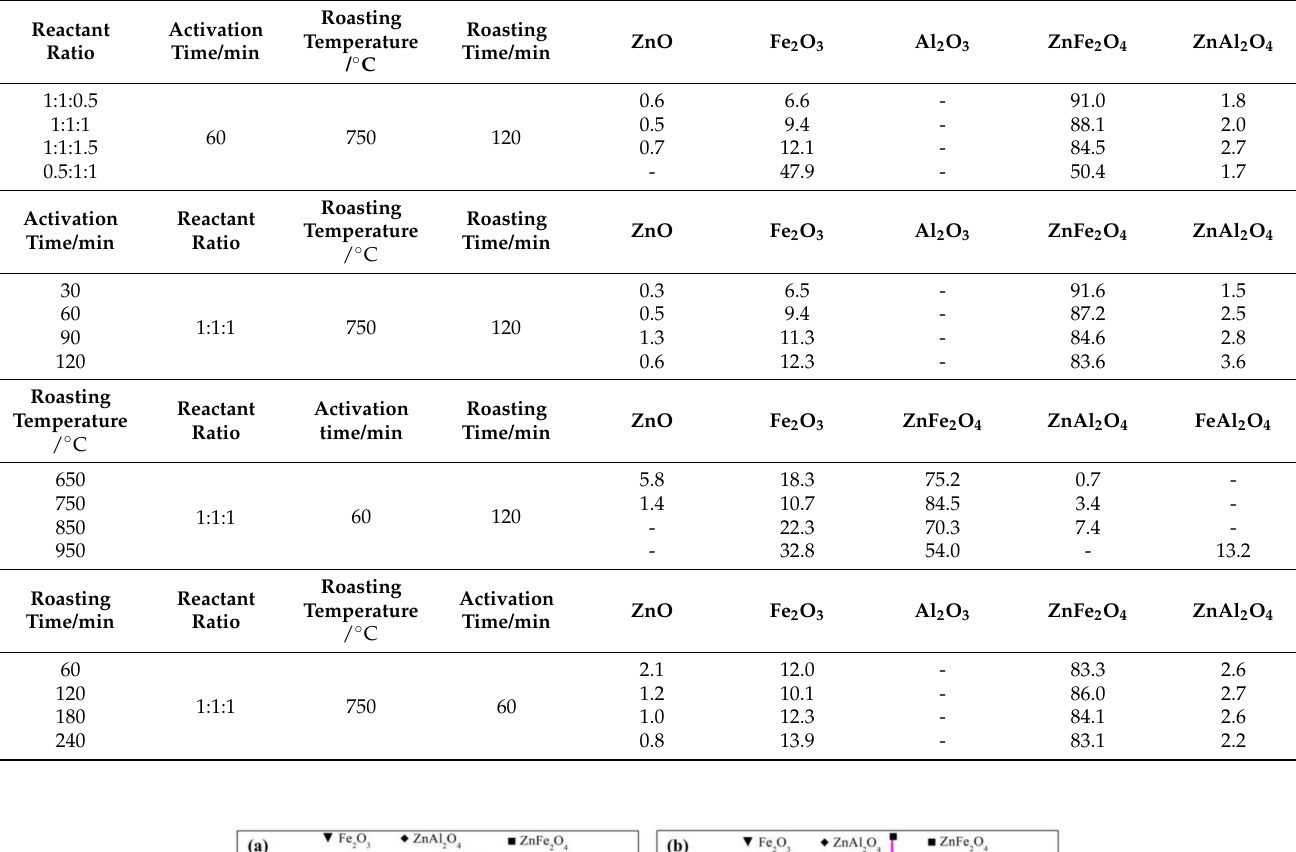
Table 1. The contents of products under a different molar ratio of ZnO, Fe 2 O 3 , and Al 2 O 3 (%).